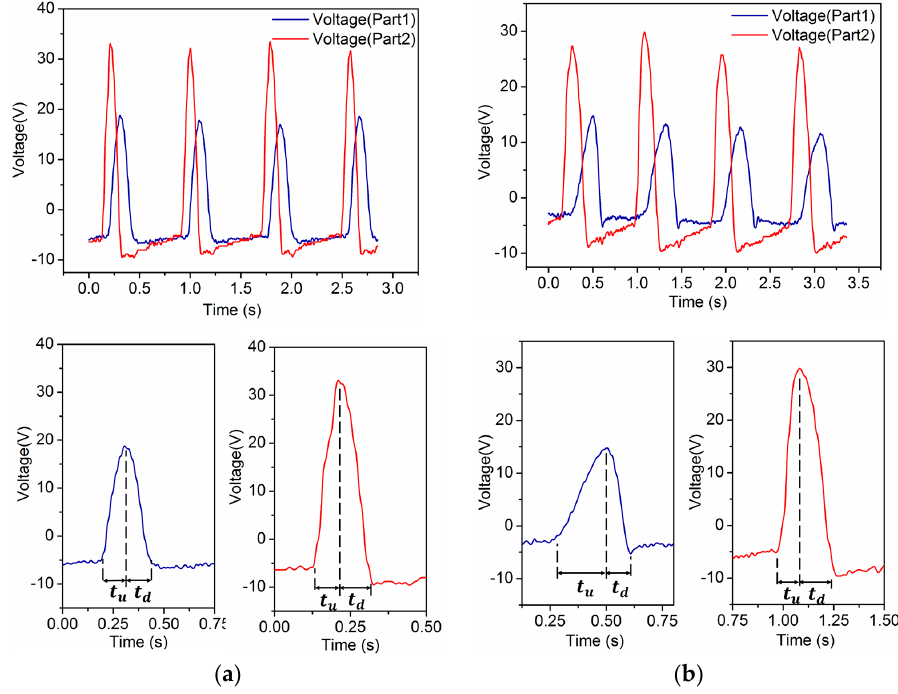
Figure 5. Waveforms and characteristics of voltage output from self-powered insole. ( a ) Waveforms and characteristics of jogging, t u ≈ t d in voltage of part1 and part2; ( b ) Waveforms and characteristics of brisk walking, t u − t d in voltage of part1 is less than that of normal walking, while t u > t d .